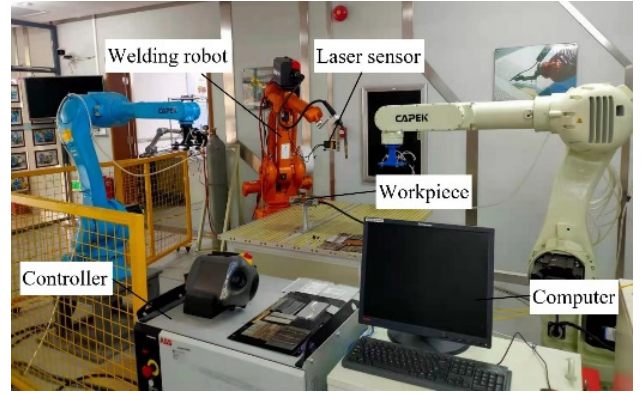
Figure 9. A prototype of the experimental system.